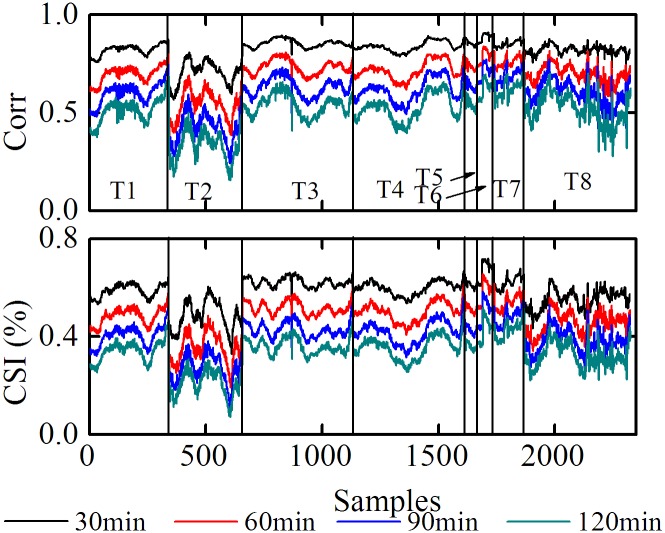
Coefficient of correlation (Corr) and critical success index (CSI) of QPN using Pyramid Lucas-Kanade Optical Flow method (PPLK) vs. 30 min, 60 min, 90 min and 120 min lead time.for 2338 images of 8 periods using Pixel-based.